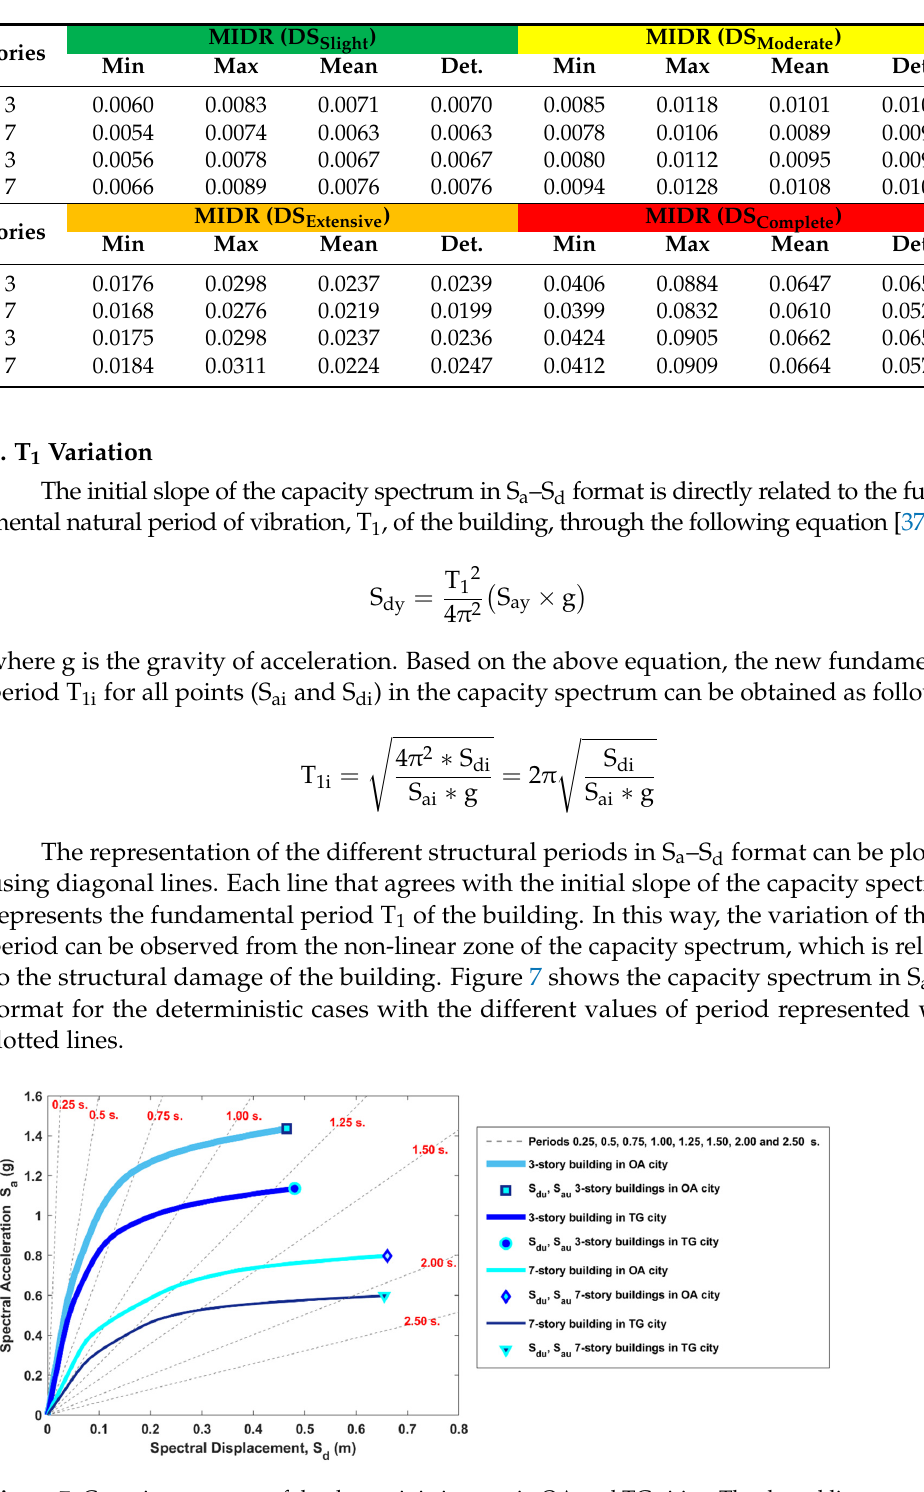
Table 6. Minimum, mean, maximum probabilistic, and deterministic values of the MIDR for each DS non-null from the Risk-UE guideline in the buildings.